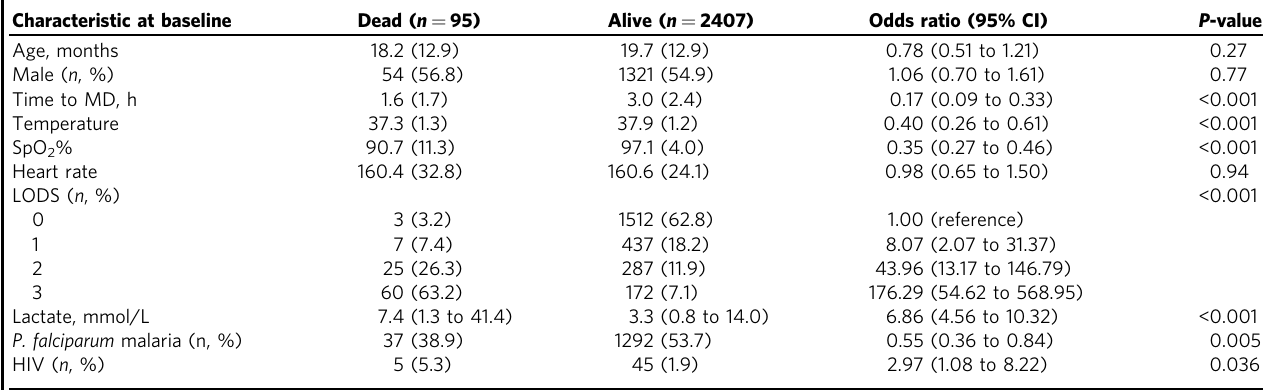
Table 1 Baseline characteristics of children who died within 7 days and children who survived until regular discharge from hospital, abscondment or